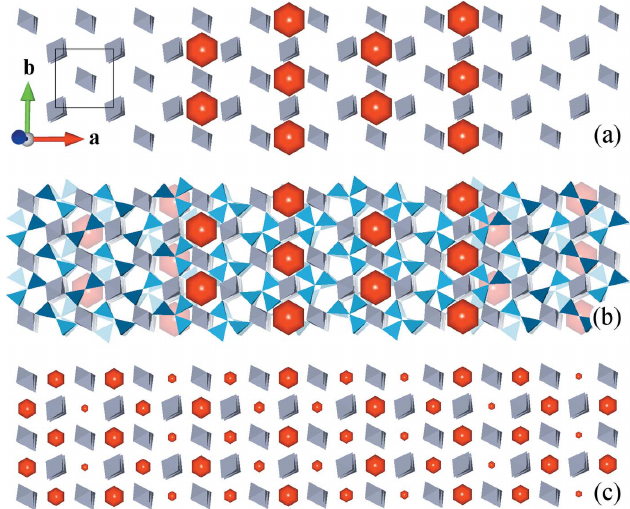
Figure 8 Comparison of the distribution of vacancies (red hexagons). ( a ) Vacancy distribution within one layer derived from the simplest model in superspace group Pbam ( a 0 1 )0 ss with q = (0.3 0 0.5) and a vacancy 2 concentration of 0.4 at coordinates with site symmetry 2/ m , which is either vacant (red hexagon) or not vacant. This distribution can be derived without any knowledge of the average structure or chemistry of mullite. Average unit-cell borders (black) and octahedra (grey) are included for visual orientation. ( b ) Vacancy distribution with the structural model of the ordered superspace model. The subsequent layer, which is equal to the first layer shifted by 5 a , is also shown with reduced opacity to indicate the relative location of vacancies in layers that are separated by 1 c . ( c ) The hexagon size represents the probability that this site is vacant in the disordered SSM. In the case of SA1, this probability varies between 11.3% (smaller hexagons) and 31.5% (larger